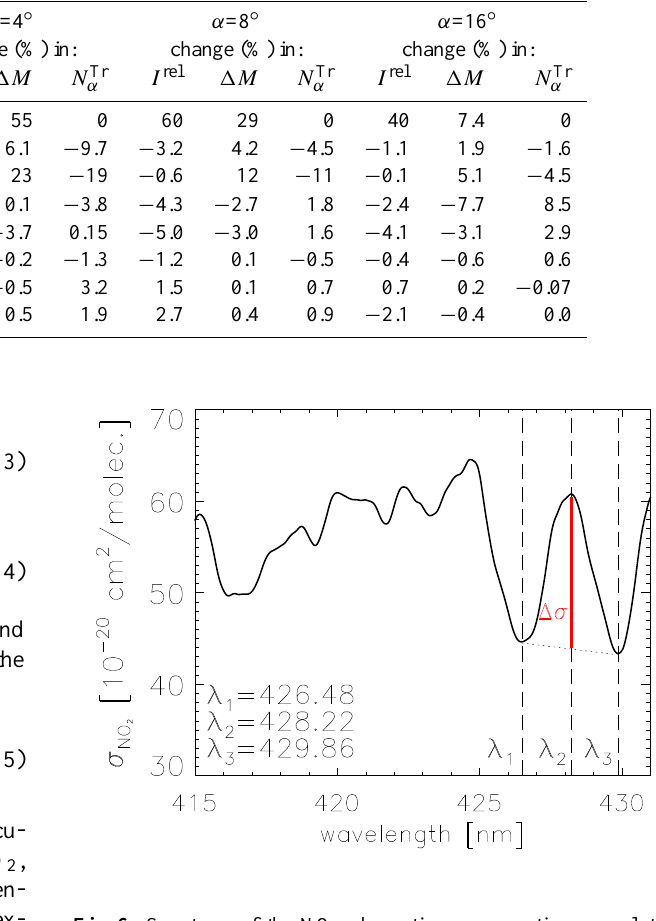
Fig. 6. Spectrum of the NO 2 absorption cross-section convoluted with the instrumental slit function. The three wavelengths λ 1 , λ 2 and λ 3 were used in the radiative transfer simulation of the differential AMF and relative intensity. The wavelength range of this figure corresponds to the DOAS spectral fitting window (see Sect. 2.3.2).